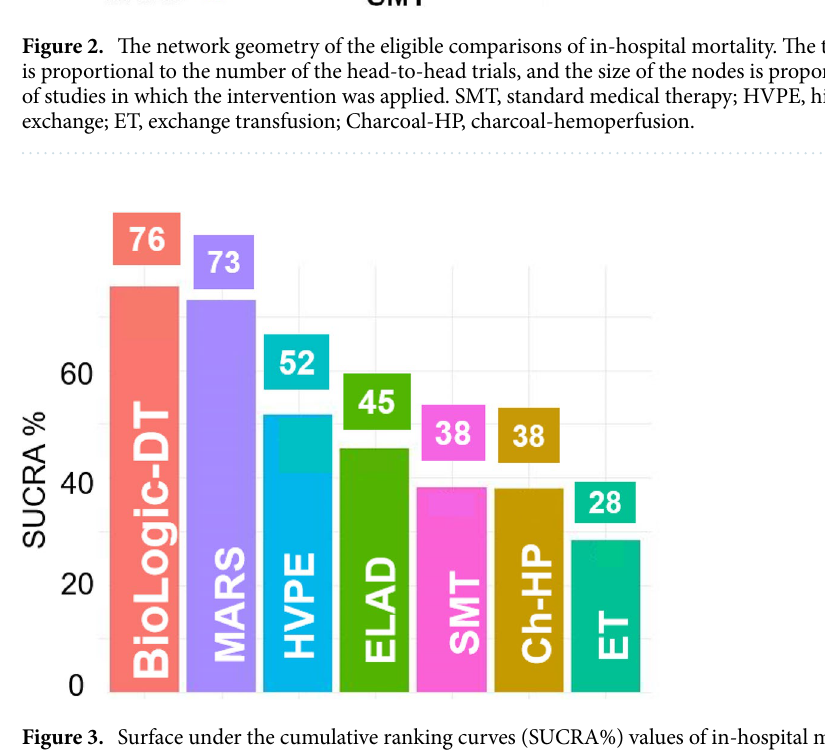
Figure 3. Surface under the cumulative ranking curves (SUCRA%) values of in-hospital mortality. Interventions were ranked by their posterior probability via calculating the surface under cumulative ranking (SUCRA) curve values. The higher the SUCRA value, the higher the probability for the interventions to be the best option. HVPE, high-volume plasma exchange; SMT, standard medical therapy; Ch-HP, Charcoal hemoperfusion; ET, exchange